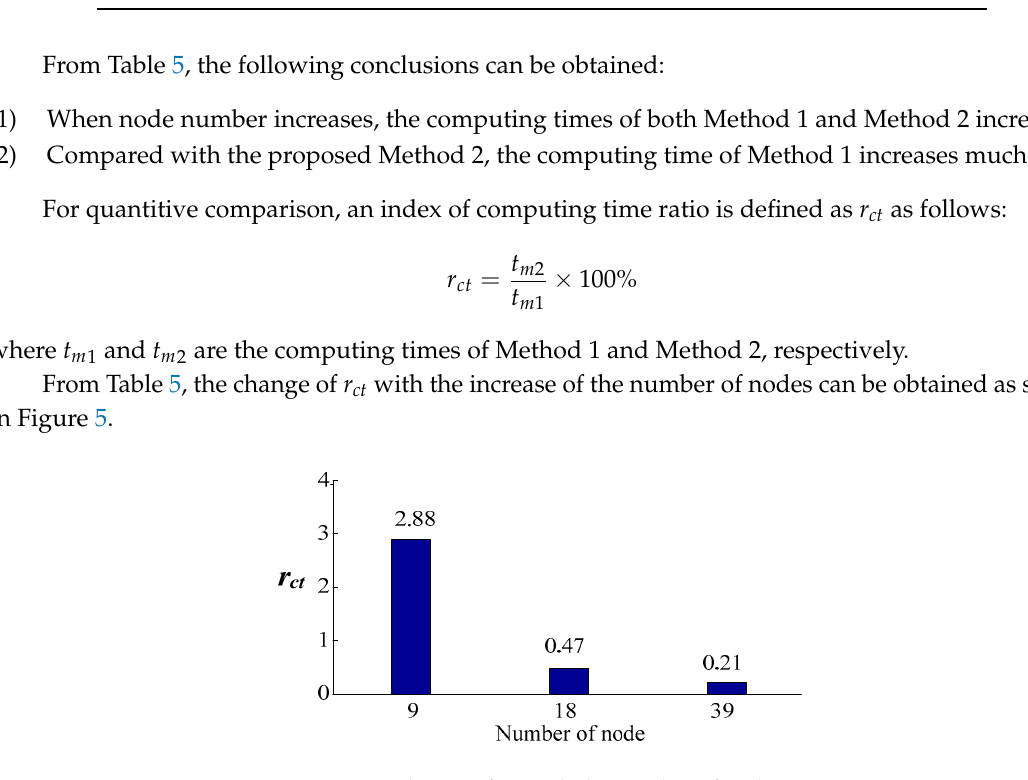
Figure 5. Change of r ct with the number of nodes.